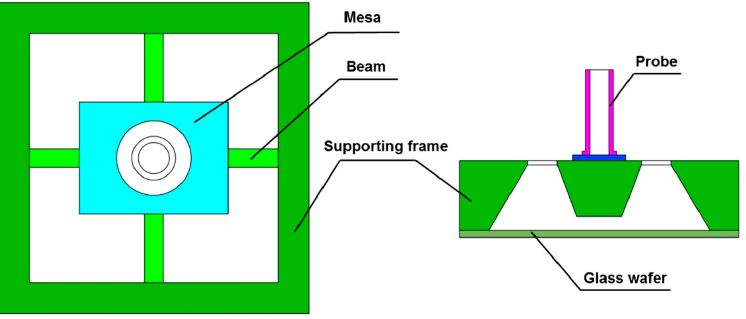
Figure 3. Schematic of the micro-force sensor (not to scale).